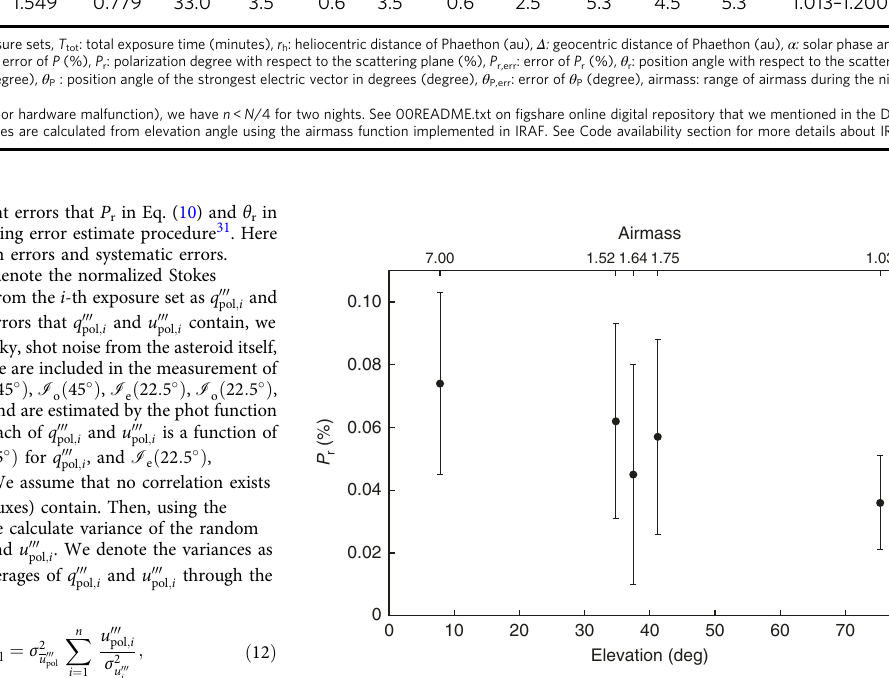
Fig. 3 Linear polarization degree of the two unpolarized standard stars ( θ UMa and HD 212311) and its dependence on airmass (elevation). We obtained the leftmost point (at airmass ~7) through the observation of θ UMa, and the other four points through the observation of HD 212311.